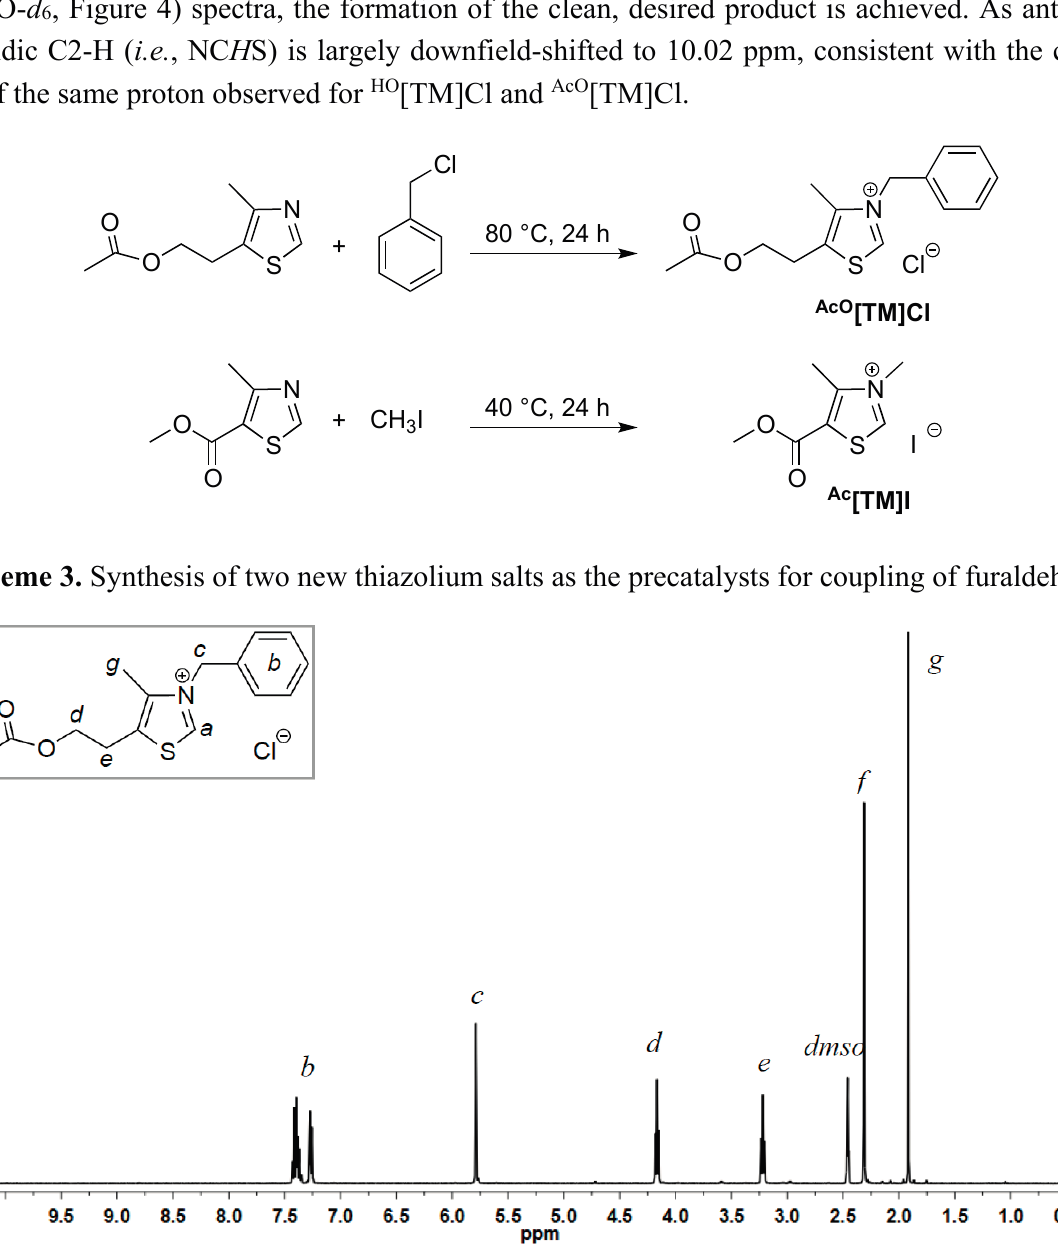
Figure 1. 1 H NMR (DMSO- d 6 ) of AcO